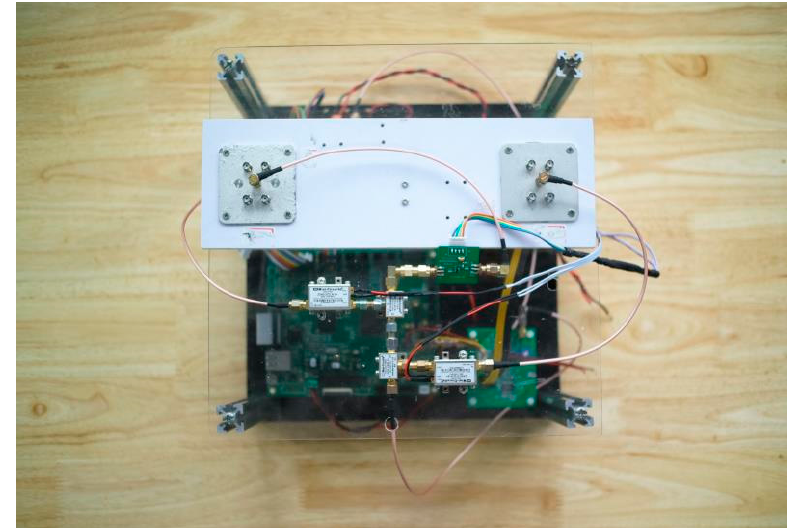
Figure 3. MIMO radar RF front end.